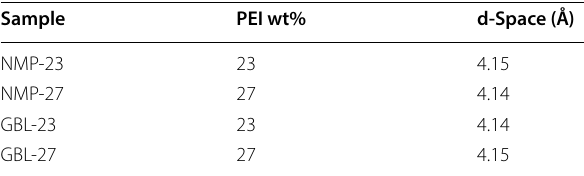
Table 7 d-Space values of NMP and GBL and membranes based on XRD data Sample PEI